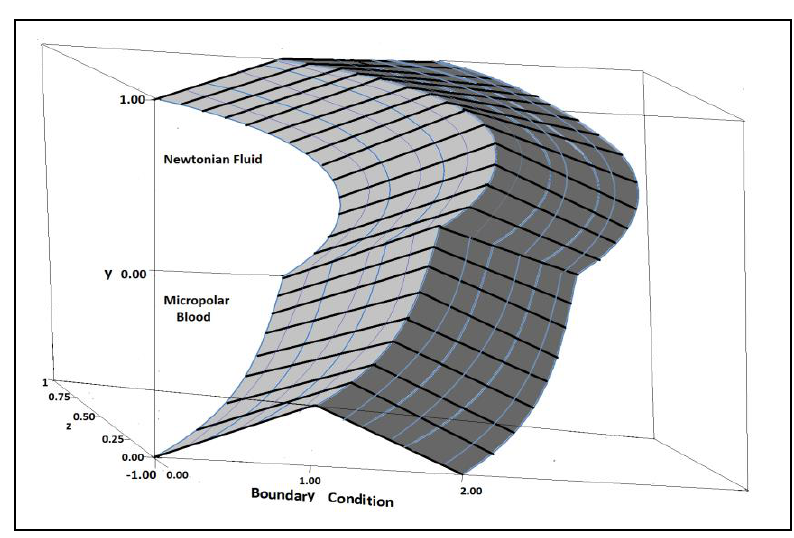
Figure 6. Evolution of membership grade for velocity profile with the fuzzy